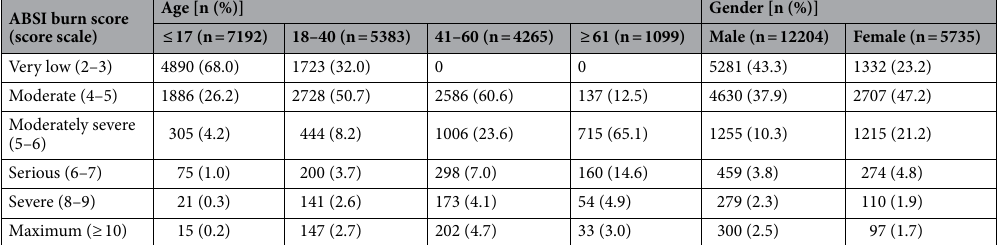
Table 3. Distribution of burn severity by age.